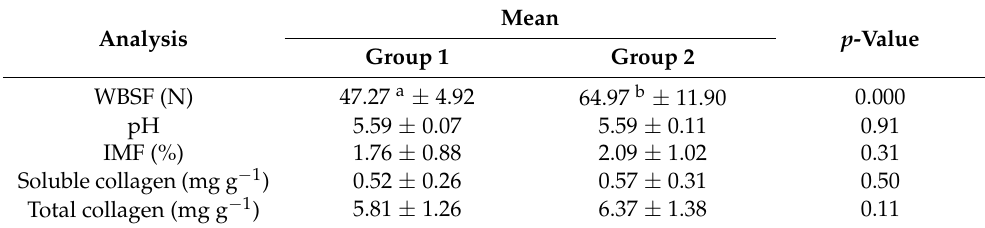
Table 1. Descriptive analysis of the groups established for the case under study.